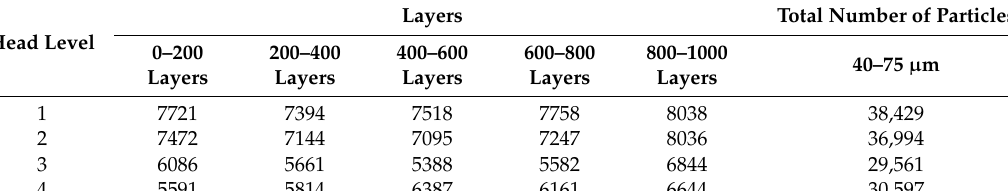
Table 10. Variation in the number of fine particles percolated with the 30% fine content (40 – 75 µm).